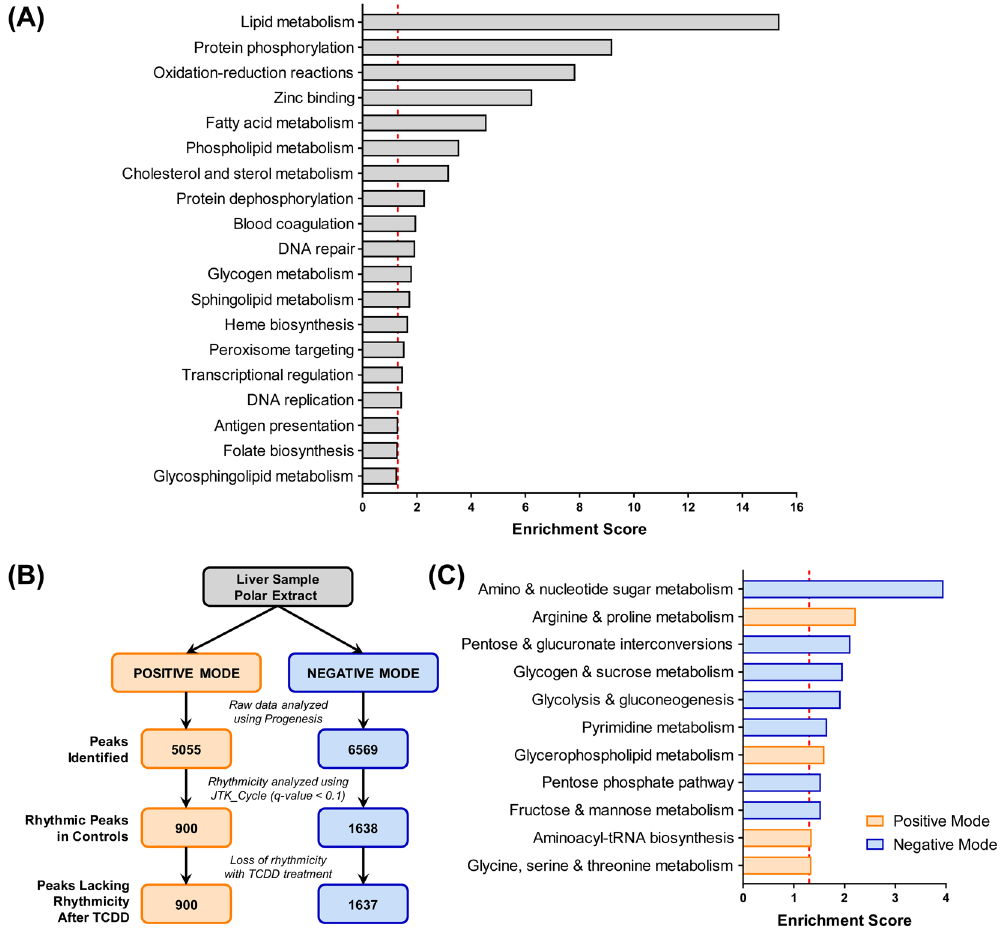
Figure 8. Functional analysis of hepatic genes and metabolites which lost their rhythmicity following TCDD treatment. Transcriptomic and metabolomic changes were assessed in male C57BL/6 mice orally gavaged with sesame oil vehicle or 30 µ g/kg TCDD every 4 days for 28 days. ( A ) The Database for Annotation, Visualization, and Integrated Discovery (DAVID) v6.8 was used to identify enriched functional clusters within 2,804 hepatic genes with abolished rhythmicity and TCDD-elicited differential expression at three or more time points. ( B ) Flow chart summarizing the analysis of an untargeted metabolomics assessment of polar hepatic extracts run in both positive and negative mode. ( C ) The mummichog algorithm in MetaboAnalyst v4.0 (MS Peaks to Pathways) was used to identify enriched KEGG pathways in the 900 and 1,637 oscillating peaks identified in positive (orange) and negative (blue) mode, respectively, which lost their rhythmicity following TCDD treatment. Scores ≥ 1.3 (red dotted line) were considered significantly